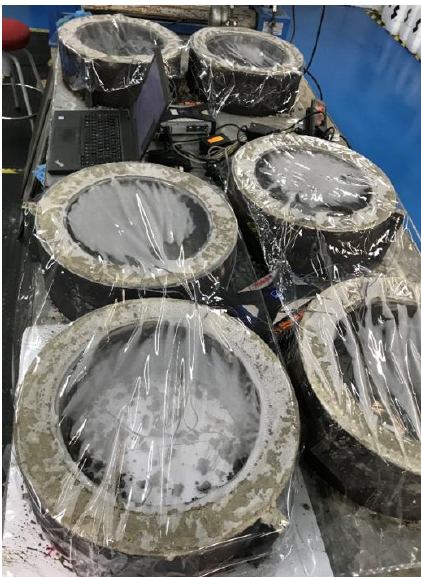
Figure 6. Concrete rings made to ascertain cracking resistance according to ASTM C1581 [57] (Picture by authors).